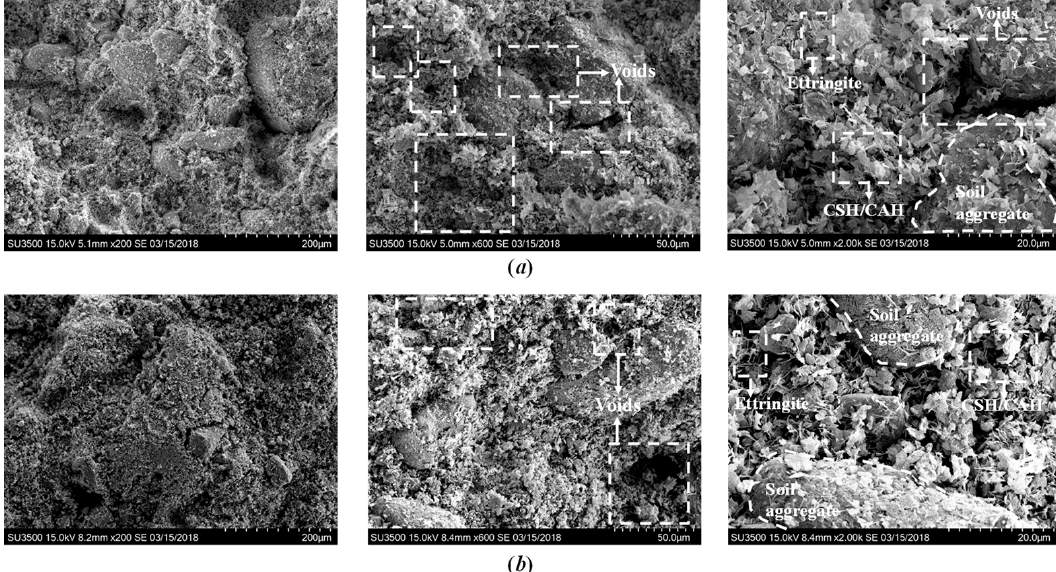
Figure 9. Scanning electron microscope (SEM) images of cemented dredged clays with ( a ) 0‰ SAP and ( b ) 1‰ SAP after 7 days of curing.